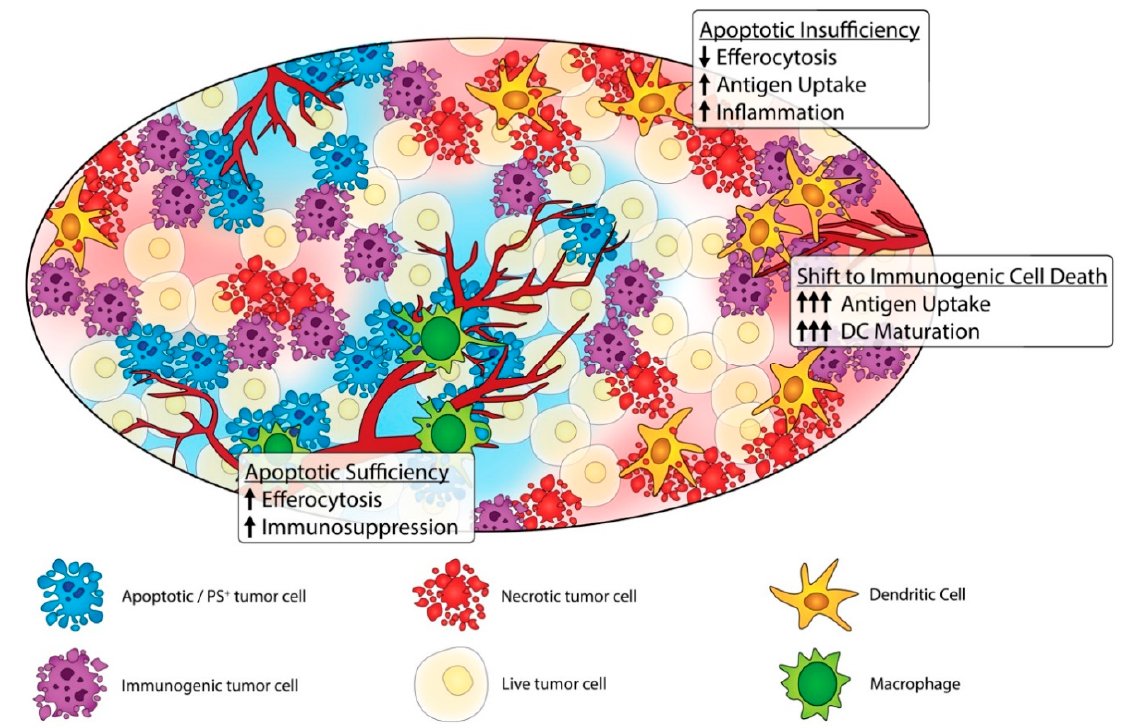
Figure 3. Heterogeneity of cell death in solid tumors. Immunosuppressive, apoptotic cells (blue) promote efferocytosis and immunosuppression, potentially promoting tumor growth. Conversely, immunogenic (purple) and necrotic (red) cells attract more antigen-presenting cells, promote antigen uptake, and encourage dendritic cell maturation resulting in a more robust anti-tumor response.